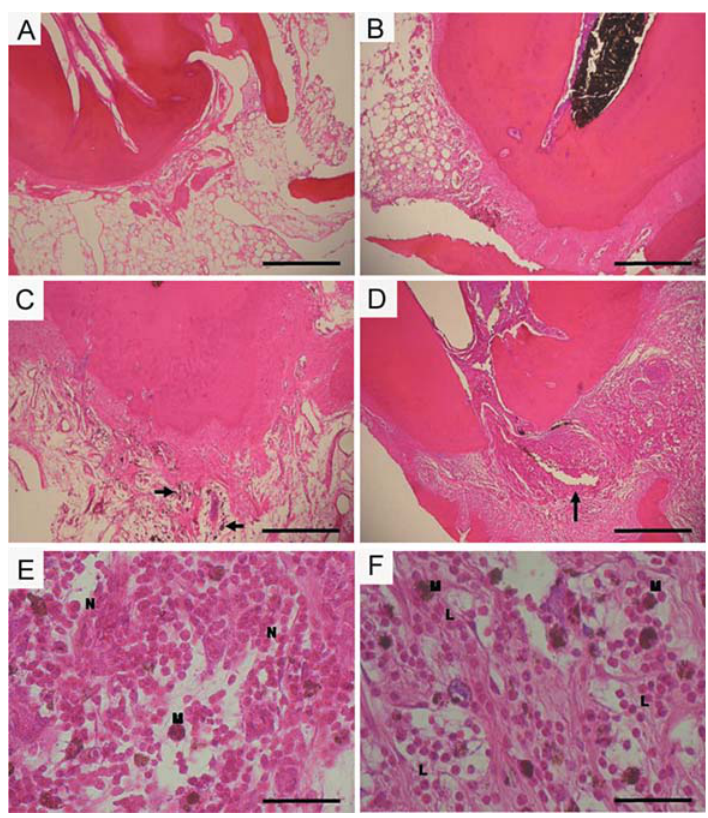
Figure 5- A- Non-treated sample – image of the periapical area of the root with a normal appearance; B- Propolis